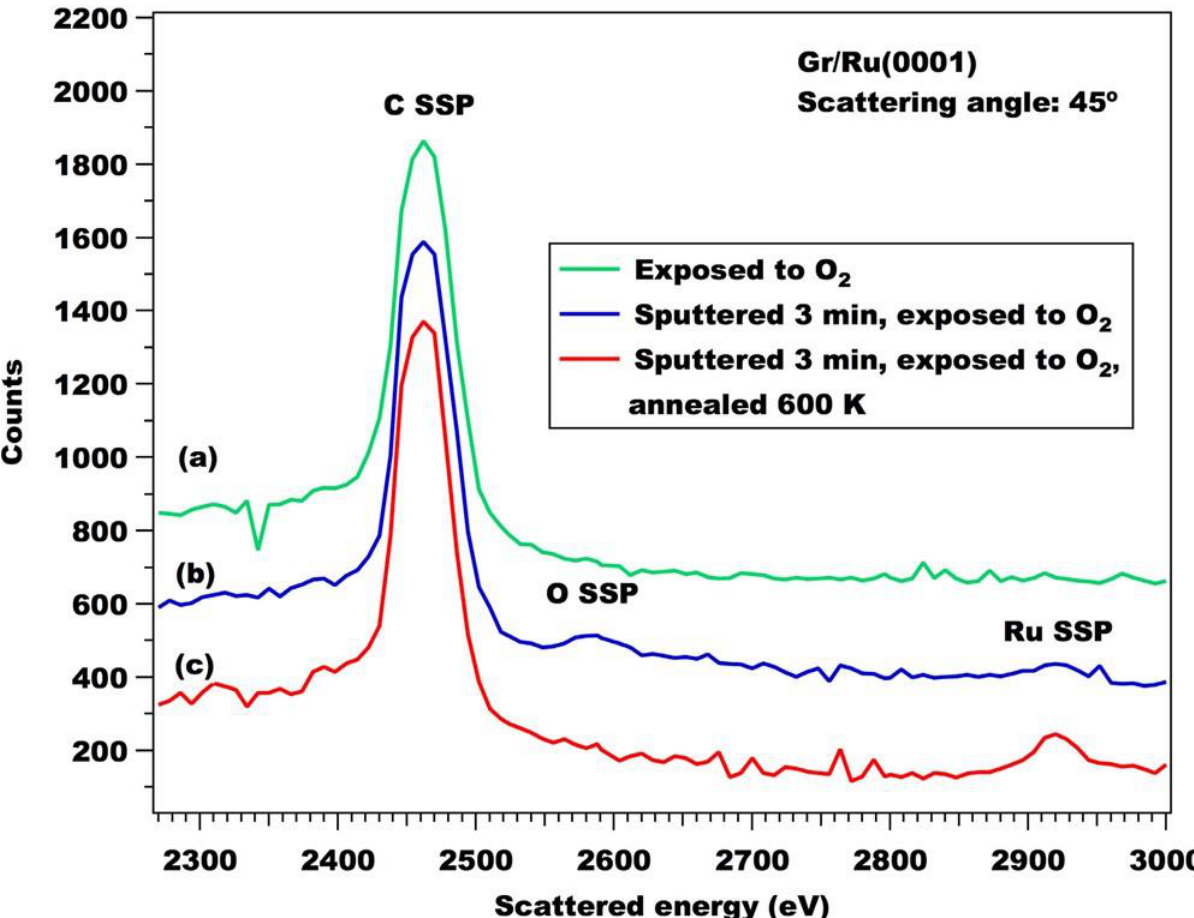
Figure 6. 3000 eV He + LEIS spectra collected at a scattering angle of 45° from ( a ) as-prepared Gr/Ru(0001) exposed to 8000 L of O 2 at 300 K, ( b ) Gr/Ru(0001) pre-sputtered for 3 min and then exposed to 1500 L of O 2 at 300 K, and ( c ) after annealing spectrum(b) to 600 K for 10 min. Taken with permission from [19]. Copyright by Elsevier.